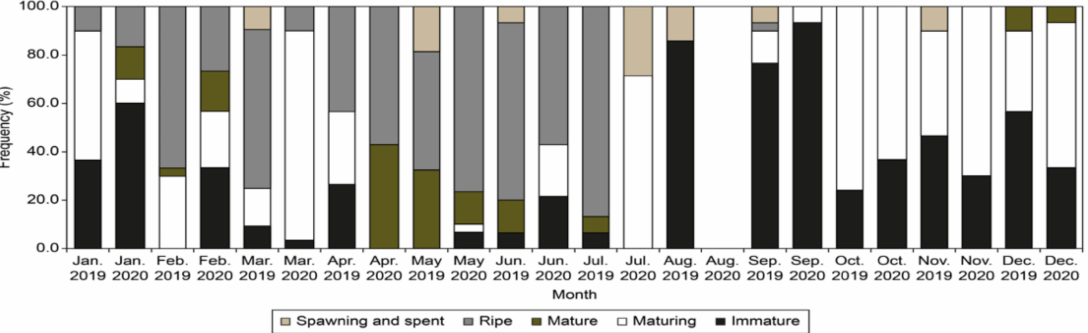
Figure 6. Temporal distribution of maturation stages in ocellate spot skate Okamejei kenojei specimens collected from the West Sea of Korea between January 2019 and December 2020.